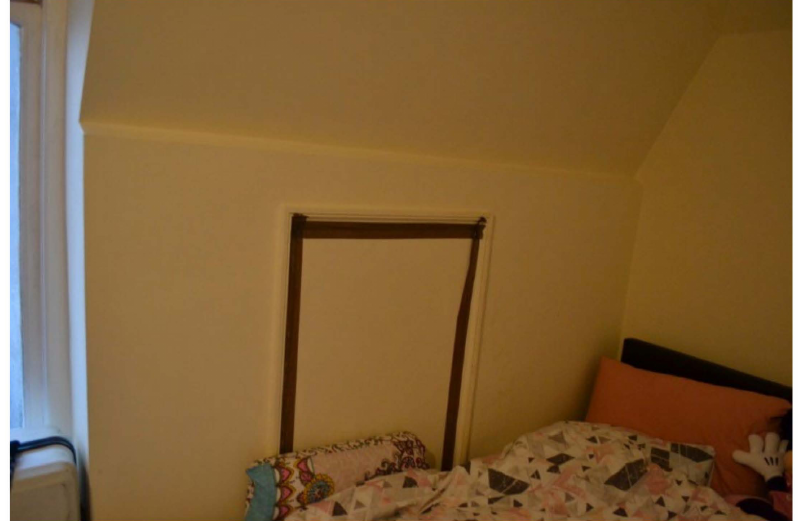
Figure 22. House visit.